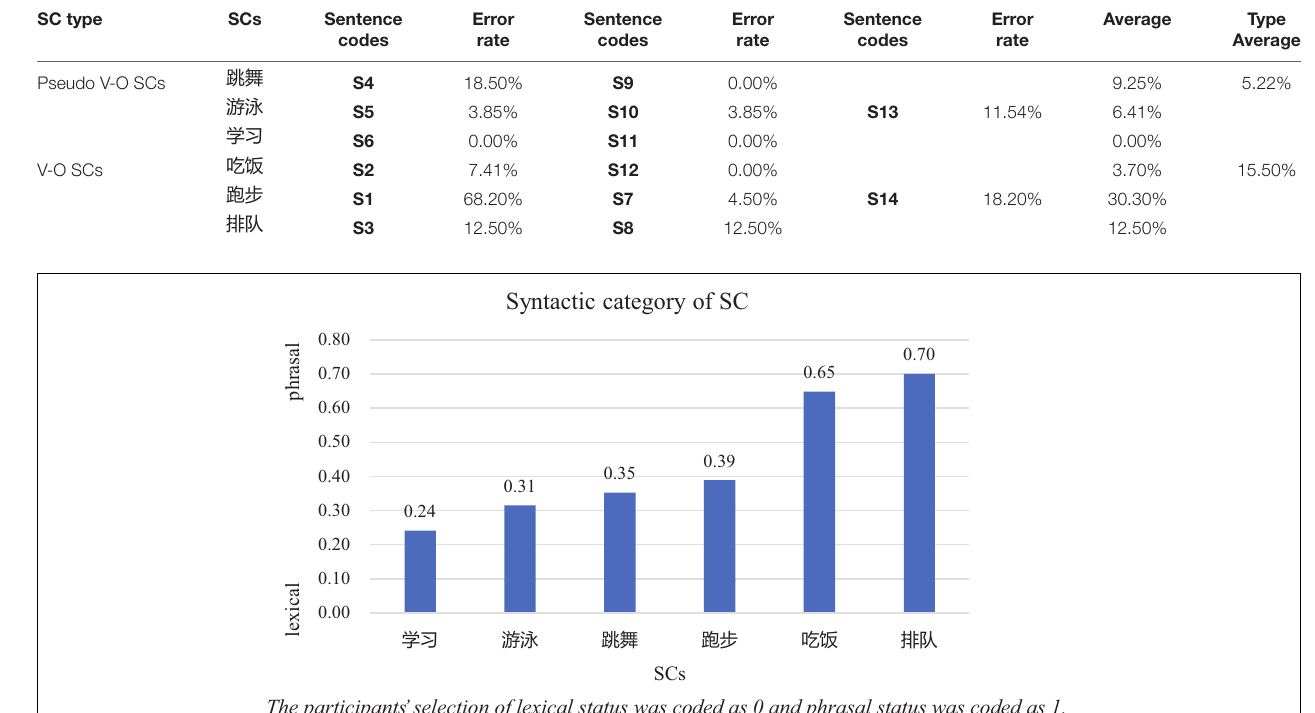
FIGURE 2 | Syntactic category of SCs based on the L2 Chinese learners’ intuition.